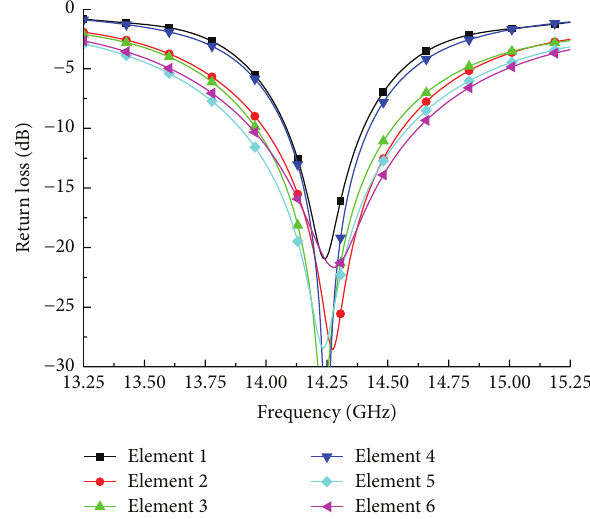
Figure 7: Return loss of designed